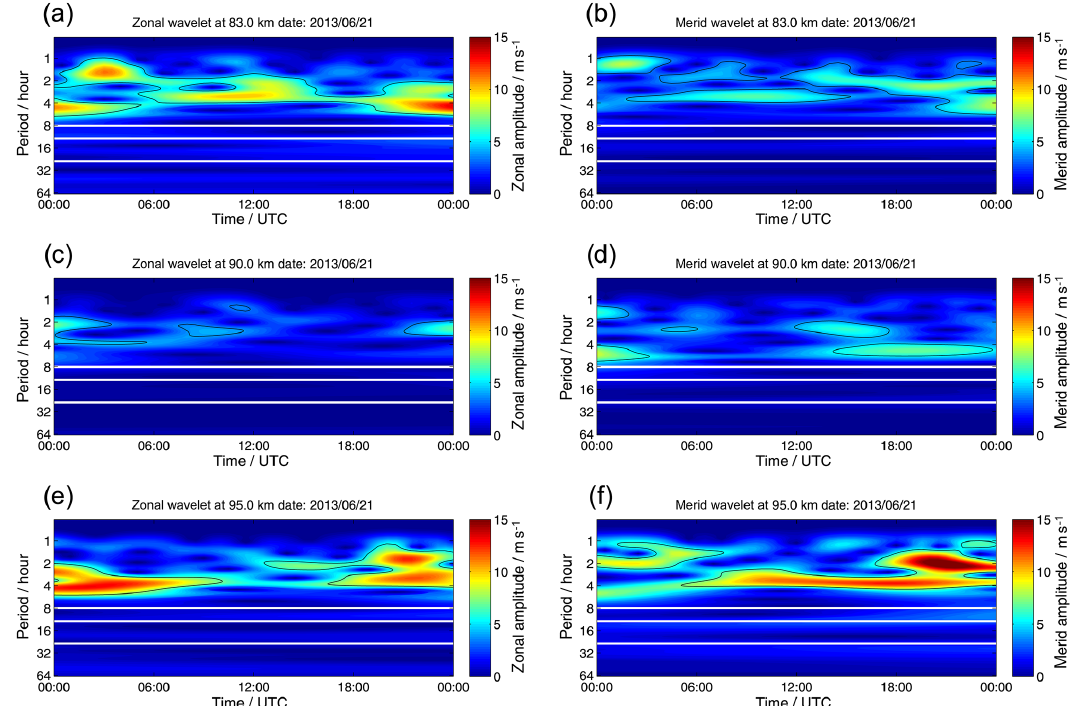
Figure 8. (a–f) Zonal and meridional amplitude wavelet spectra for different altitudes. The time series were filtered to remove the mean wind as well as the tidal components. The white lines indicate the periods of the diurnal, semidiurnal, and terdiurnal